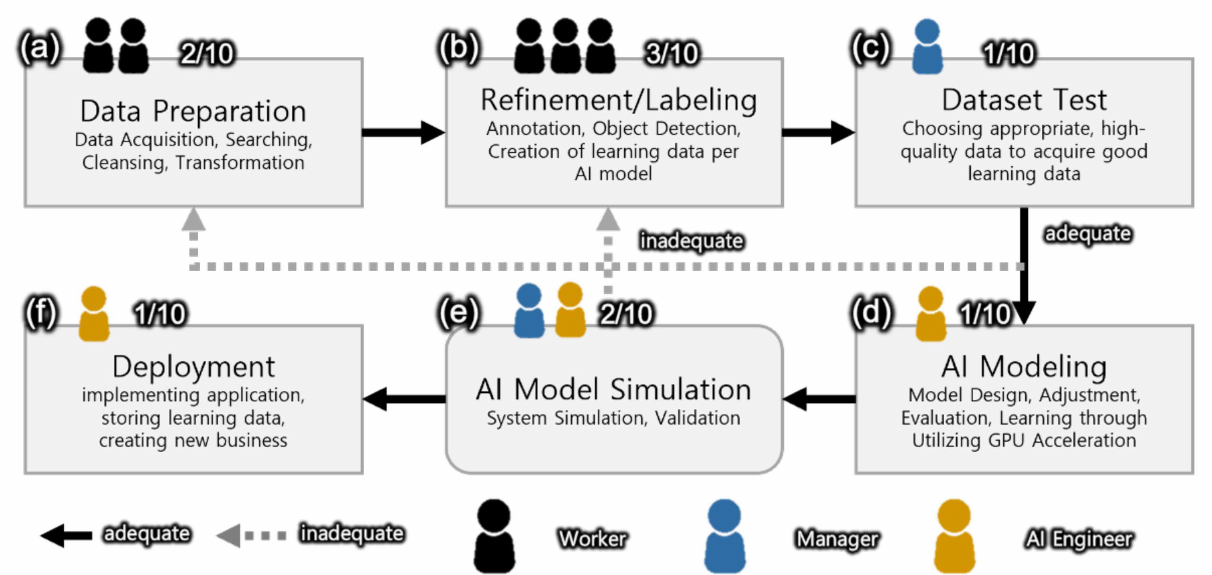
Figure 1. The current AI R&D process in academia and in the industrial field, and manpower status required for development (if 10 personnel are needed for total input, 50% of them are for data acquisition, processing, refinement, and